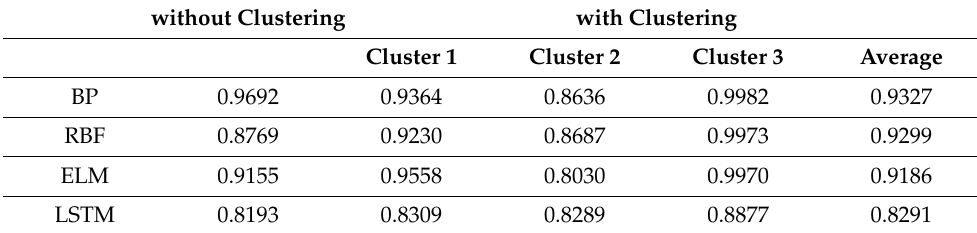
Table 12. R 2 of solar radiation in